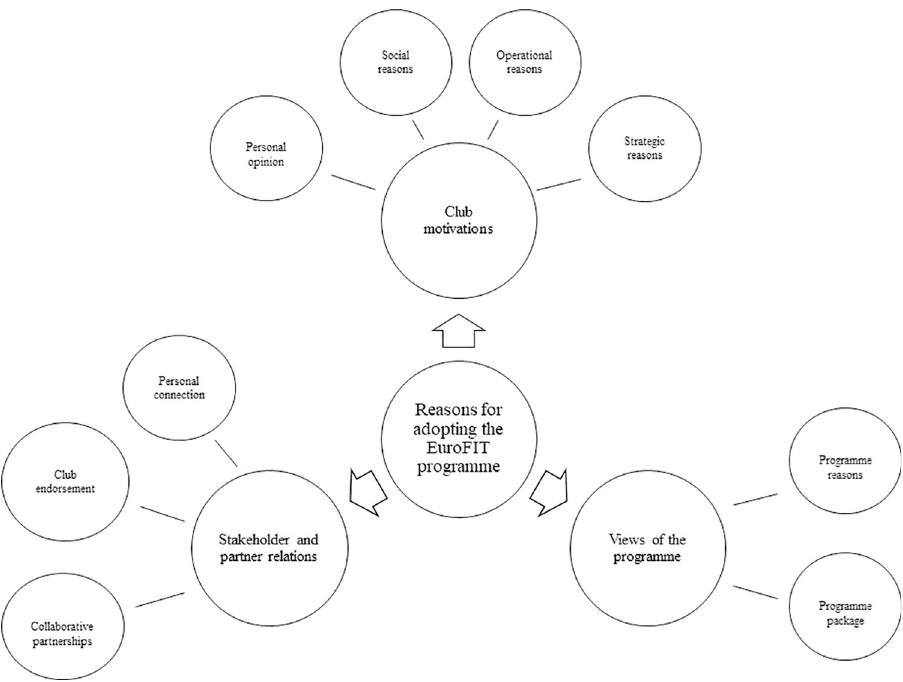
Fig 2. Main themes and sub-themes illustrating motives for adopting the EuroFIT